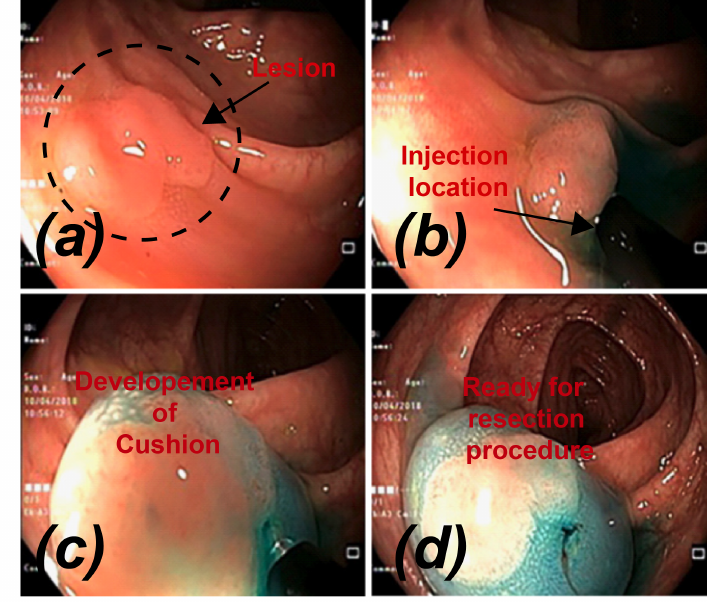
Figure 1. Procedure of submucosal injection of a colonic flat lesion